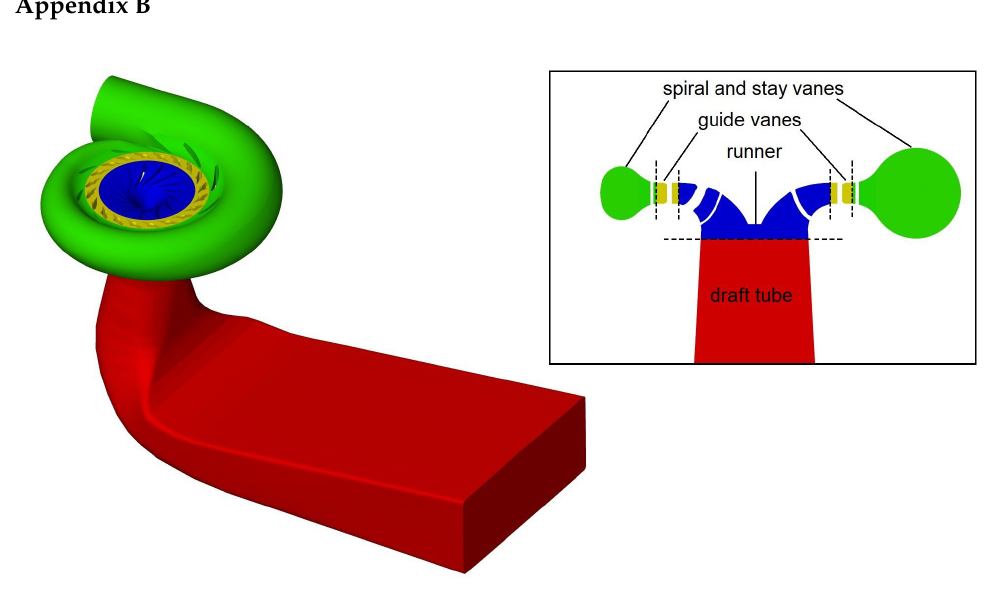
Figure A2. Visualization of the computational domain and the position of the interfaces between the turbine components, which are indicated with dashed lines.